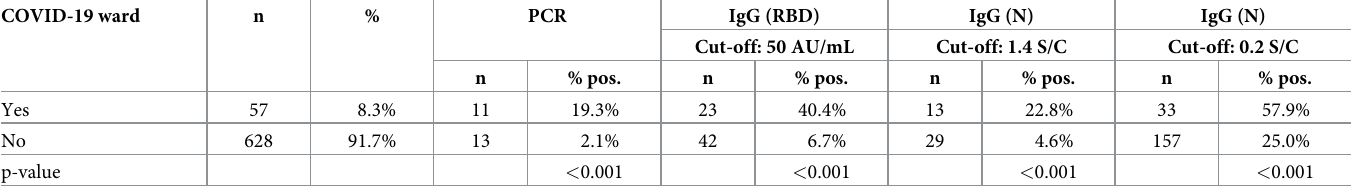
Table 3. Positive rates of PCR, IgG (RBD), IgG (N) 1.4 , and IgG (N) 0.2 in HCW’s working in COVID-19 or non-COVID-19 ward.